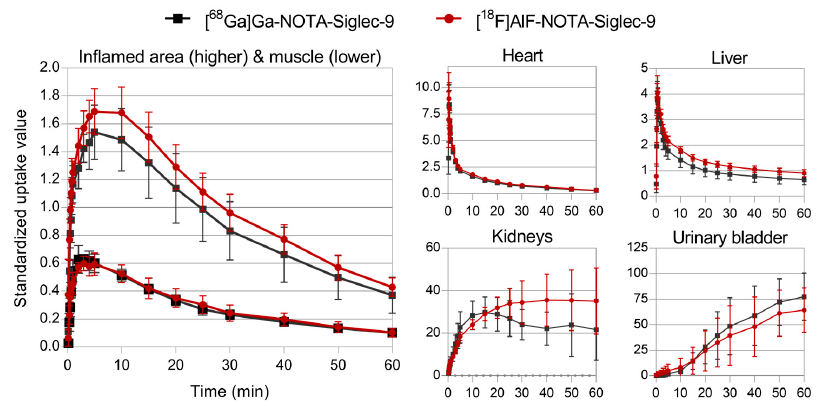
Figure 3. Time-activity curves for [ 68 Ga]Ga-NOTA-Siglec-9 and [ 18 F]AlF-NOTA-Siglec-9 ( n = 4).